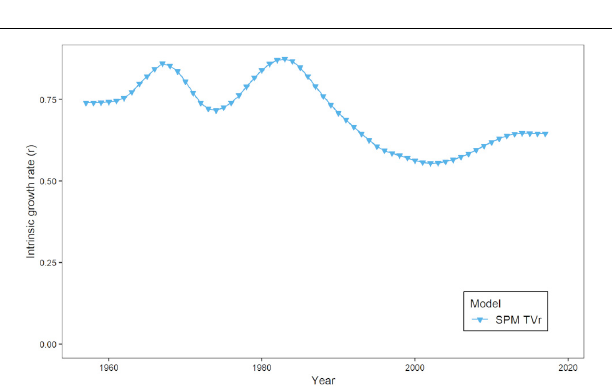
FIGURE 4 | Time-varying intrinsic growth rate, r , from the SPM TVr